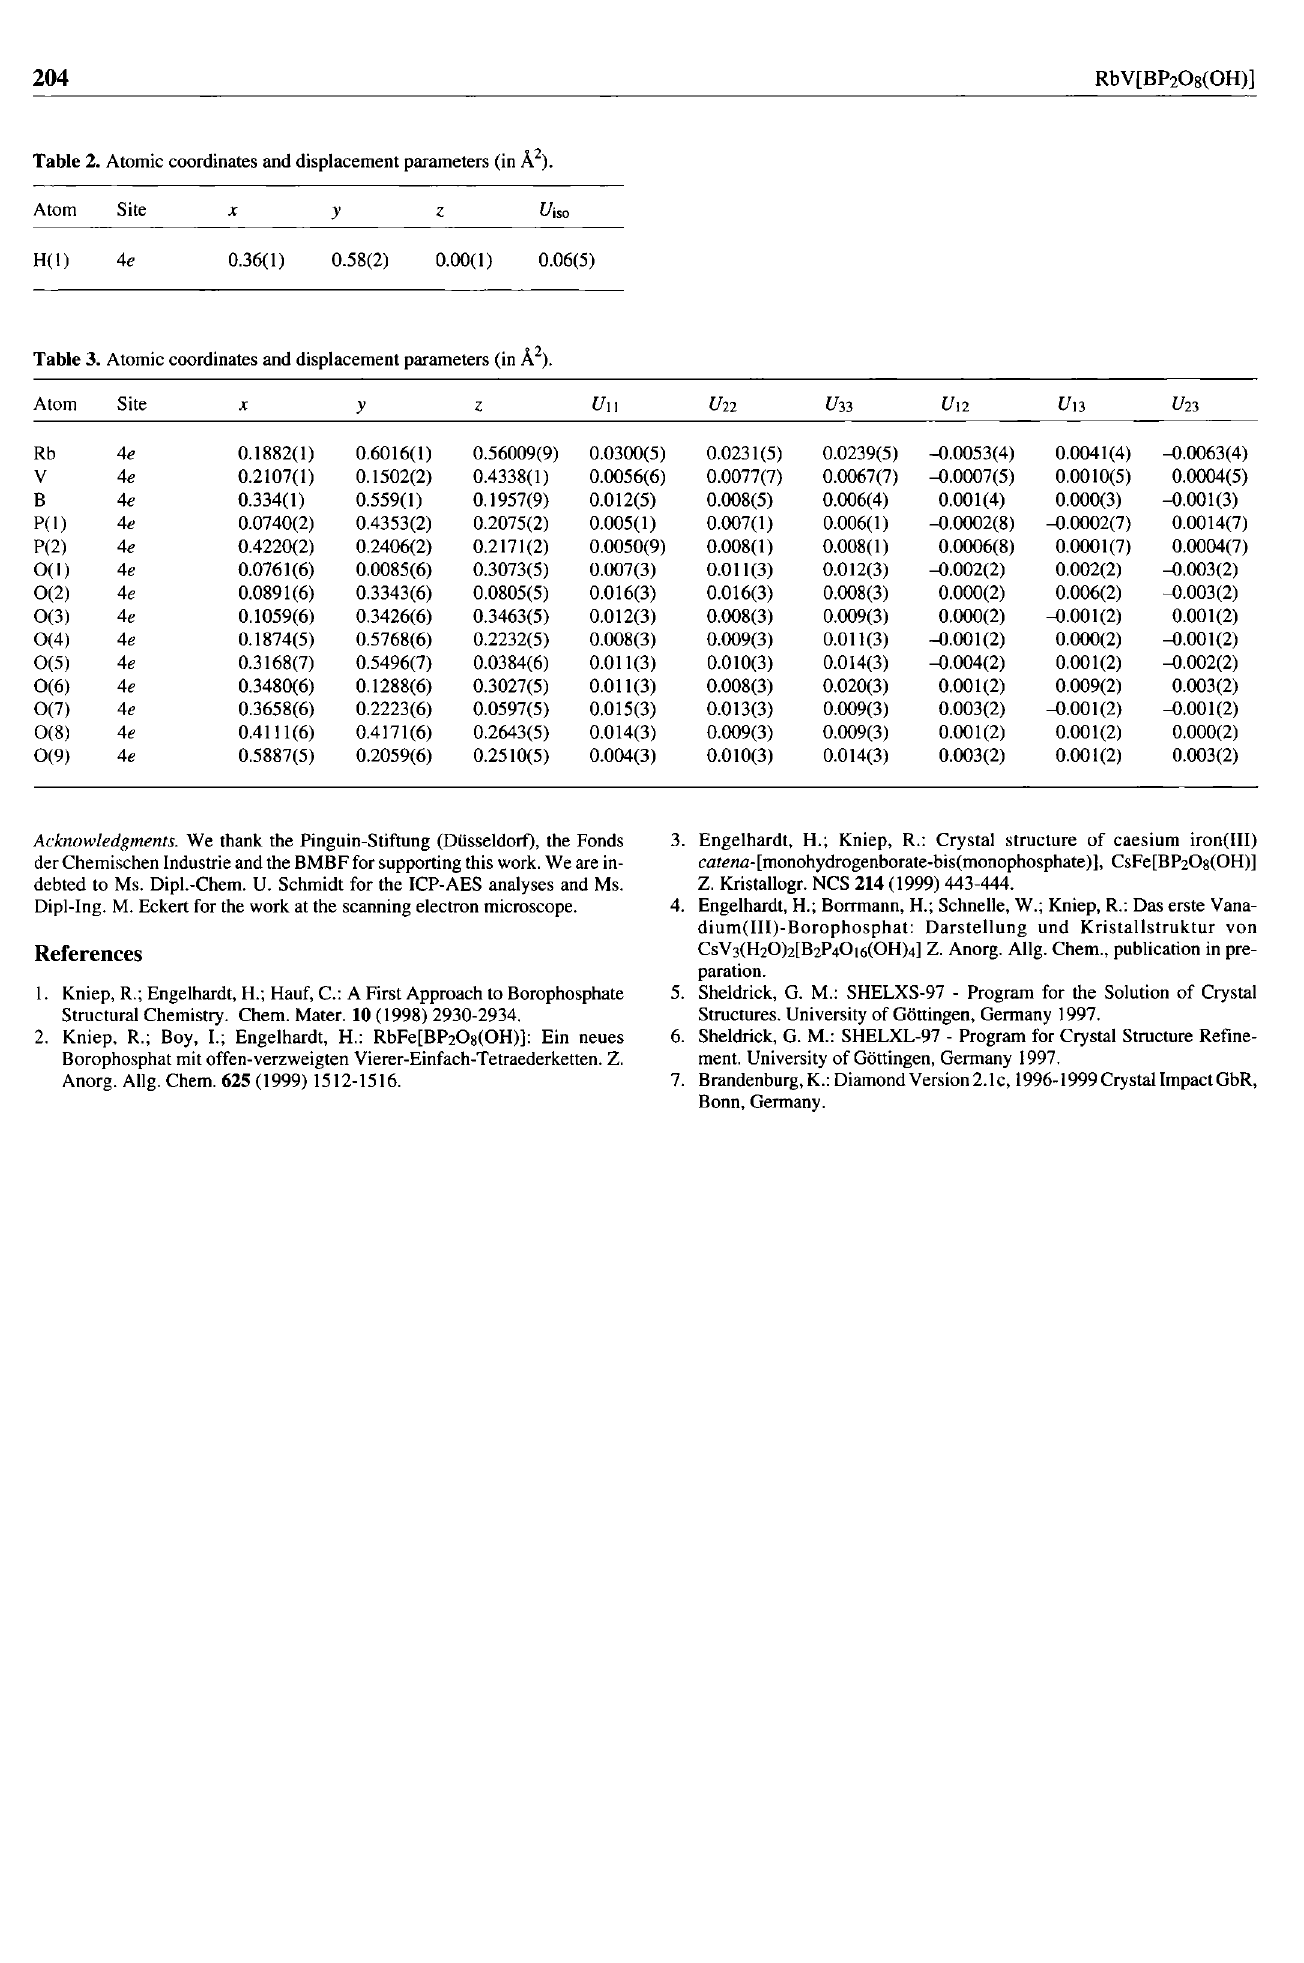
Table 2. Atomic coordinates and displacement parameters (in Ä 2 ).